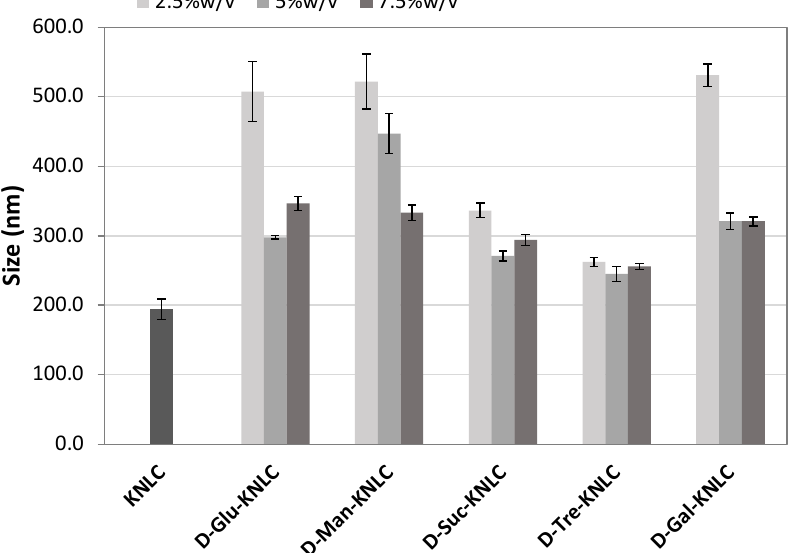
Figure 2. Size values of K-NLCs and K-NLCs freeze-dried using (2.5, 5, and 7.5)% w/v of different lyoprotectants (D-glucose anhydrous, D-mannitol, D-sucrose, D-trehalose dihydrate, and D-galactose). Data are shown as the mean ± standard deviation ( n = 3).